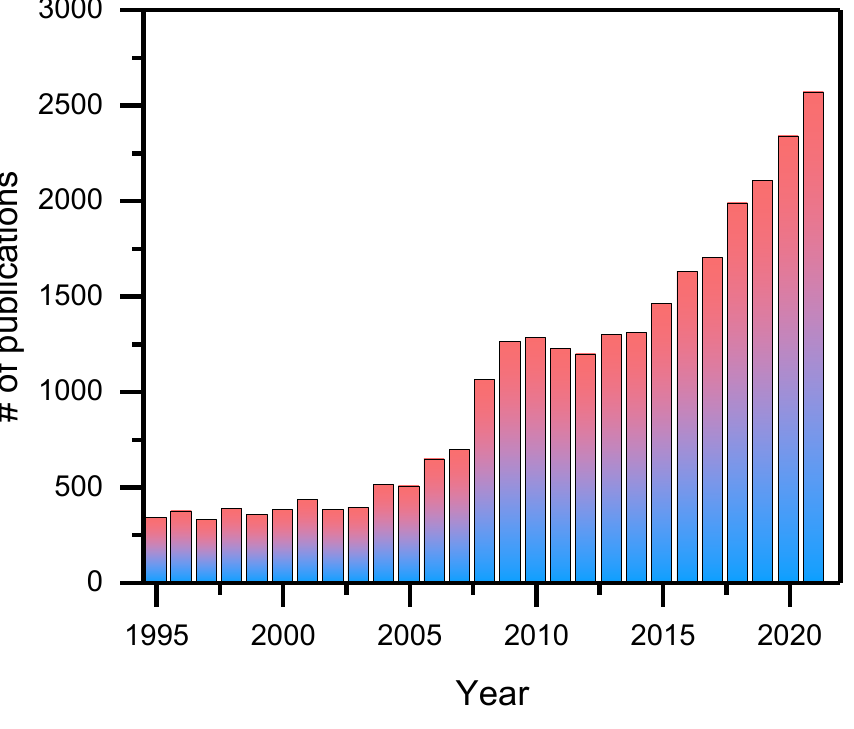
Figure 1. Number of publications in the area of gas sensors from 1995 to 2021 (data gathered from Scopus database).